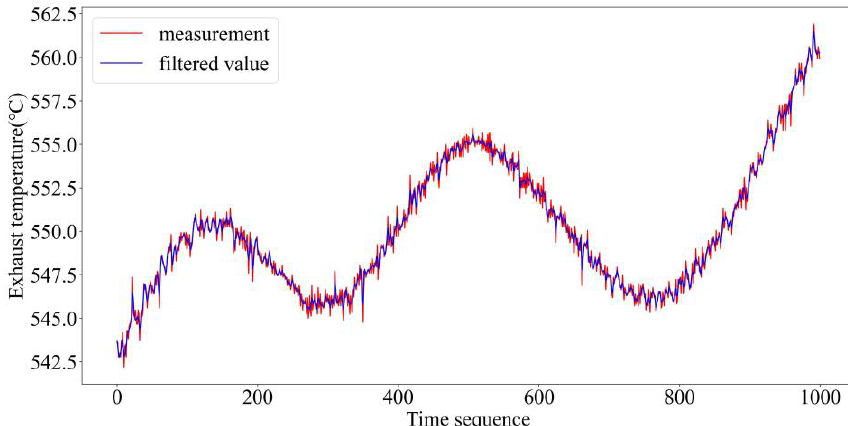
Figure 6. Exhaust temperature after filtering.